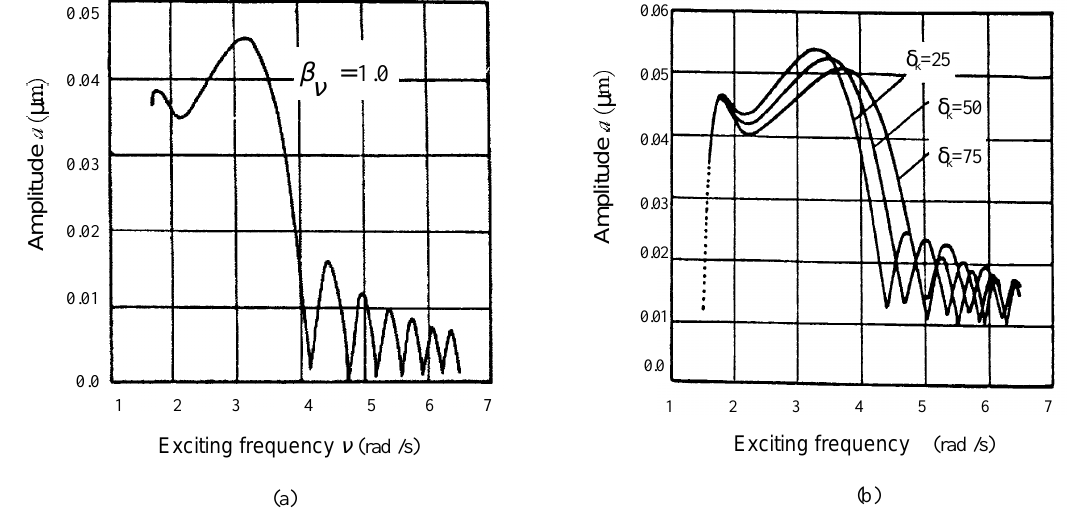
Fig. 1. (a). The response of the system with slow-changing exciting frequency. (b). The response of the system with slow-changing stiffness. tems, an explicit approximate solution was derived, based on the technique of freezing slowly